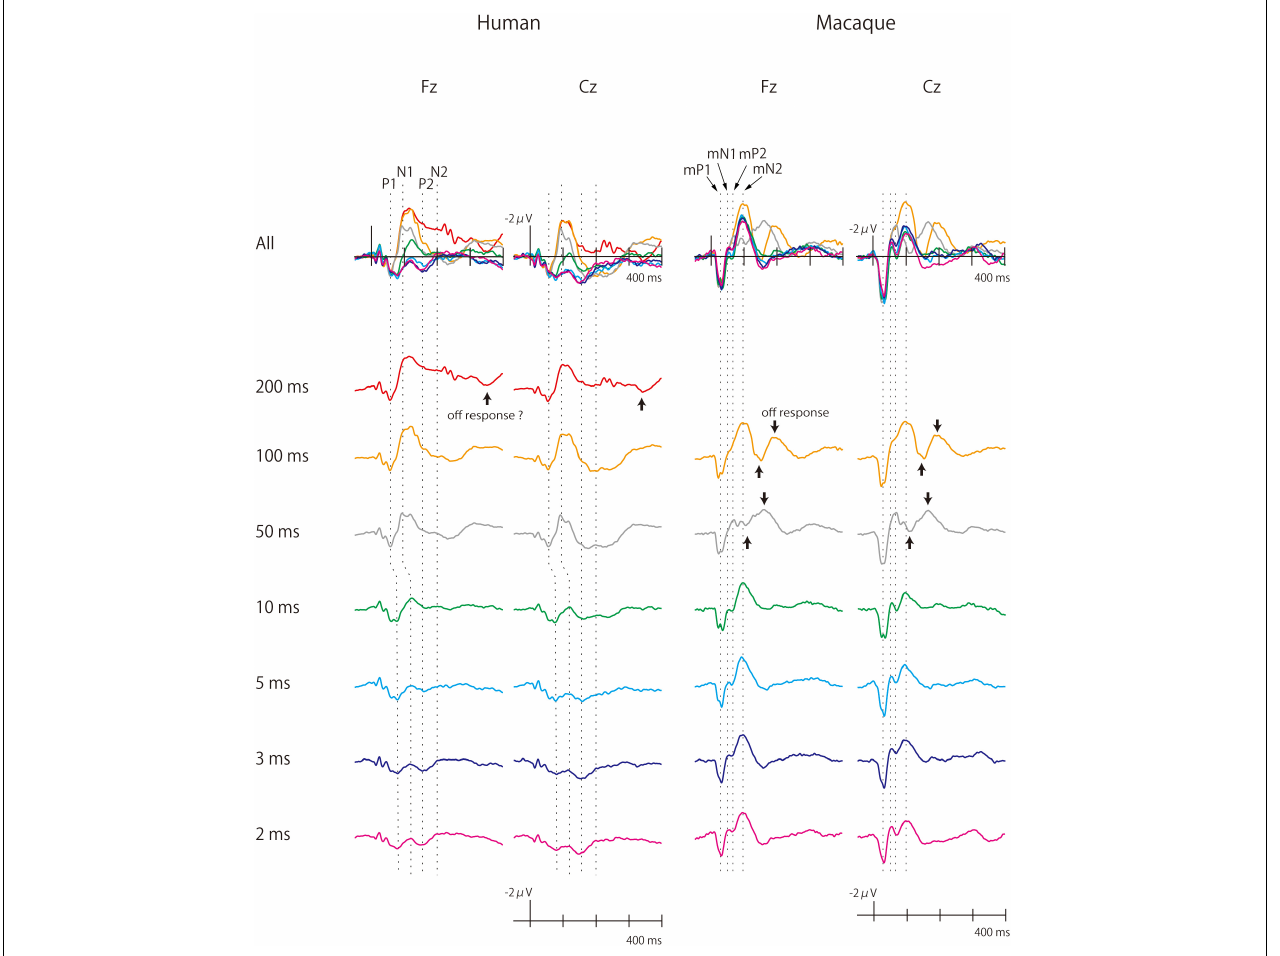
FIGURE 1 | Human and monkey scalp-recorded CAEPs elicited by pure-tone stimuli of different durations. The macaque cortex continued to produce large CAEPs as sound duration was shortened. Off-responses were observed more clearly in monkeys.